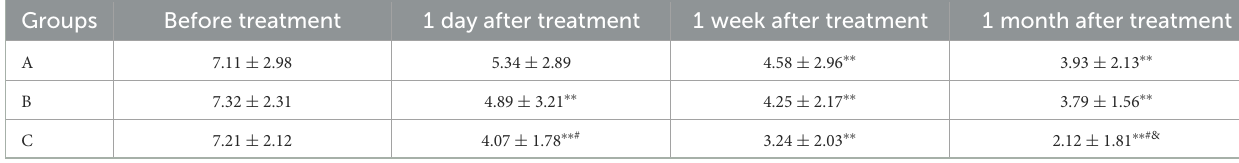
TABLE 2 VAS scores of patients before and after treatment (mean ± SD).